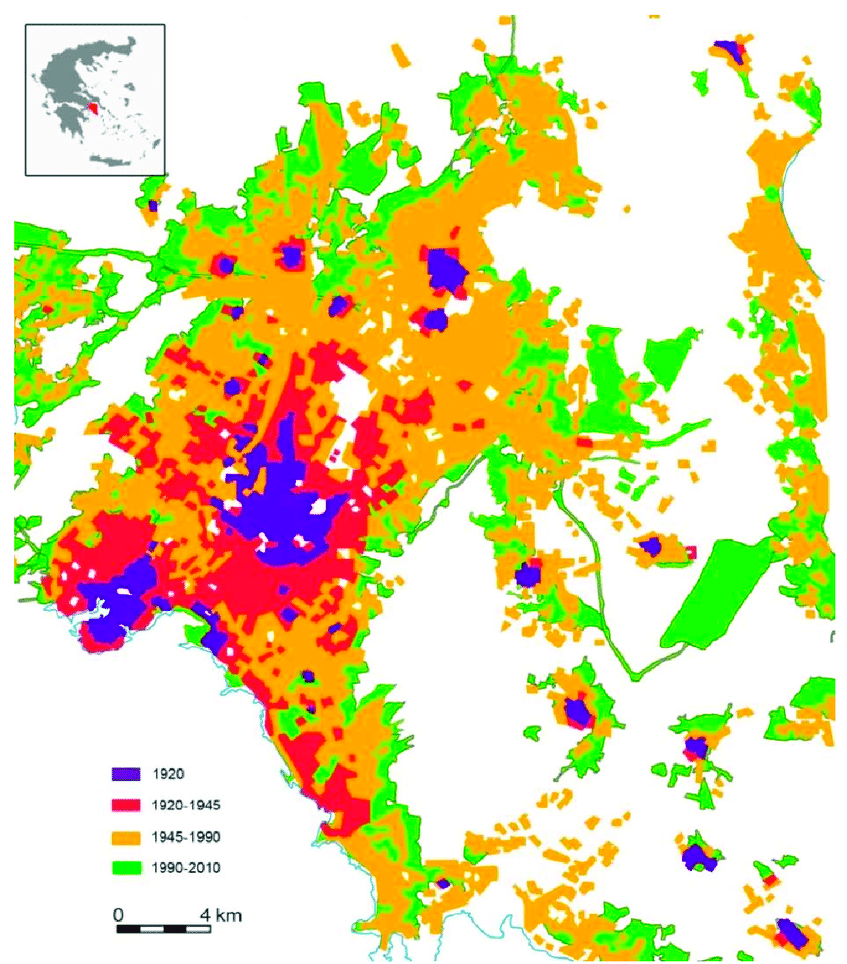
Figure 1. The urban development of Athens over the past 100 years [16].